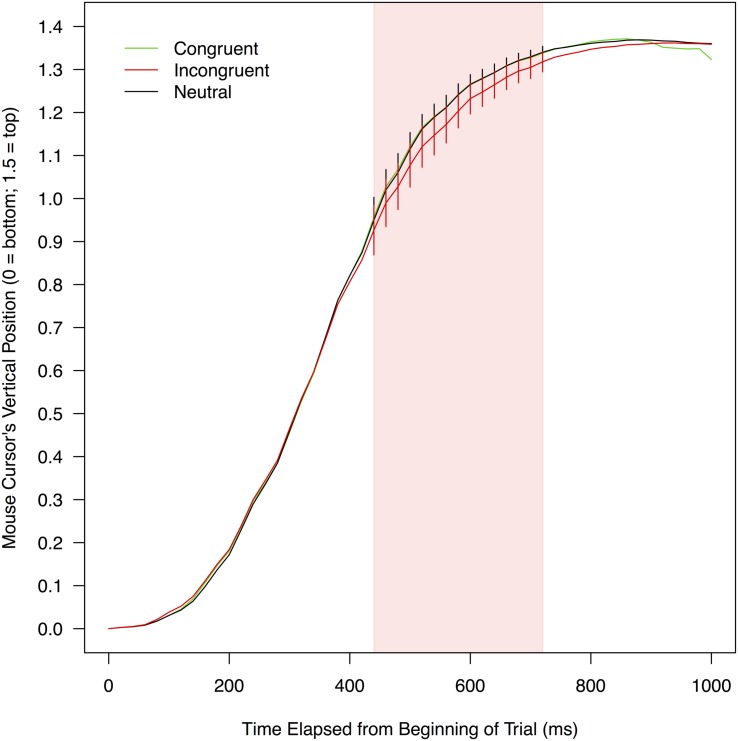
Mean vertical positions of a mouse cursor on a screen as a function of experimental conditions and the time elapsed from the beginning of a trial. To compute these means, leftward trajectories were bilaterally flipped and pooled with rightward trajectories (for details, see section “Mouse Trajectory” under “RESULTS” of the text). The red shade indicates the time range (440–740 ms) in which mouse movements toward correct responses were significantly delayed when stimulus color words were written in incongruent colors (compared to when the stimulus words were neutrally colored in white). Error bars shown in this range represent 95% confidence intervals.